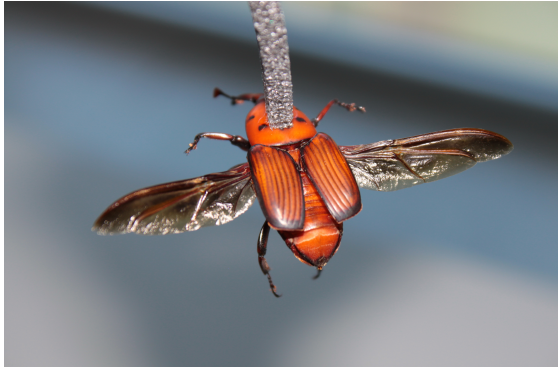
Figure 15. Detail of the tethering of an R. ferrugineus adult to a piece of